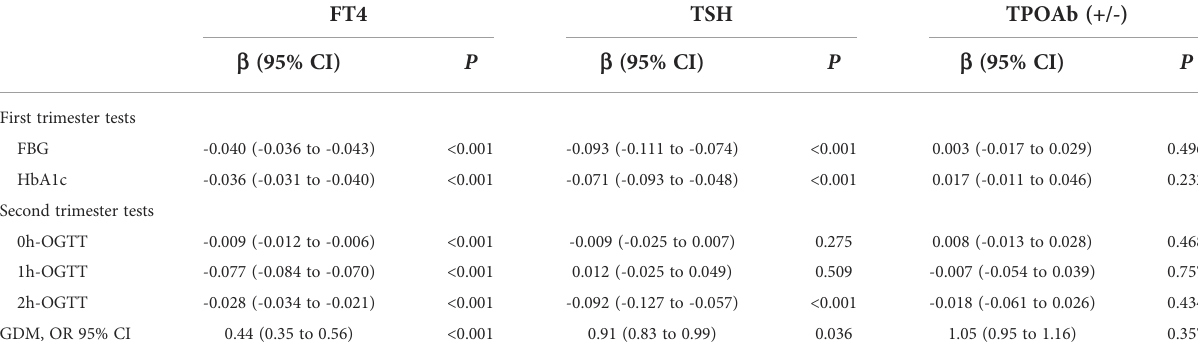
TABLE 3 Association of thyroid hormone levels with glucose measurements and gestational diabetes mellitus